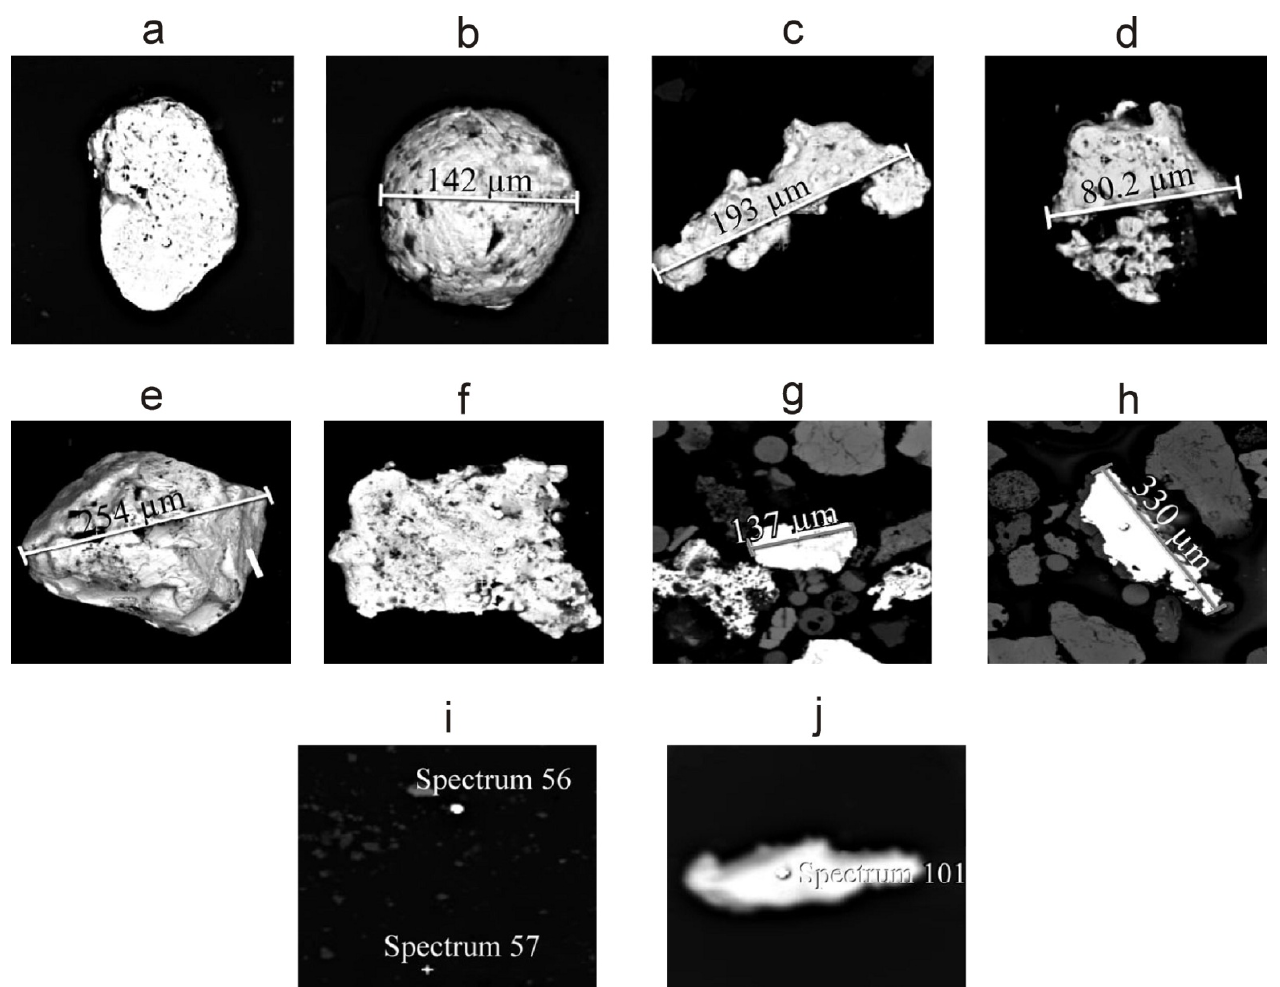
Figure 7. Native gold particles with mineral inclusions extracted from ( а – d ) slags, ( e – h ) fly ash, and ( i – j ) slime.